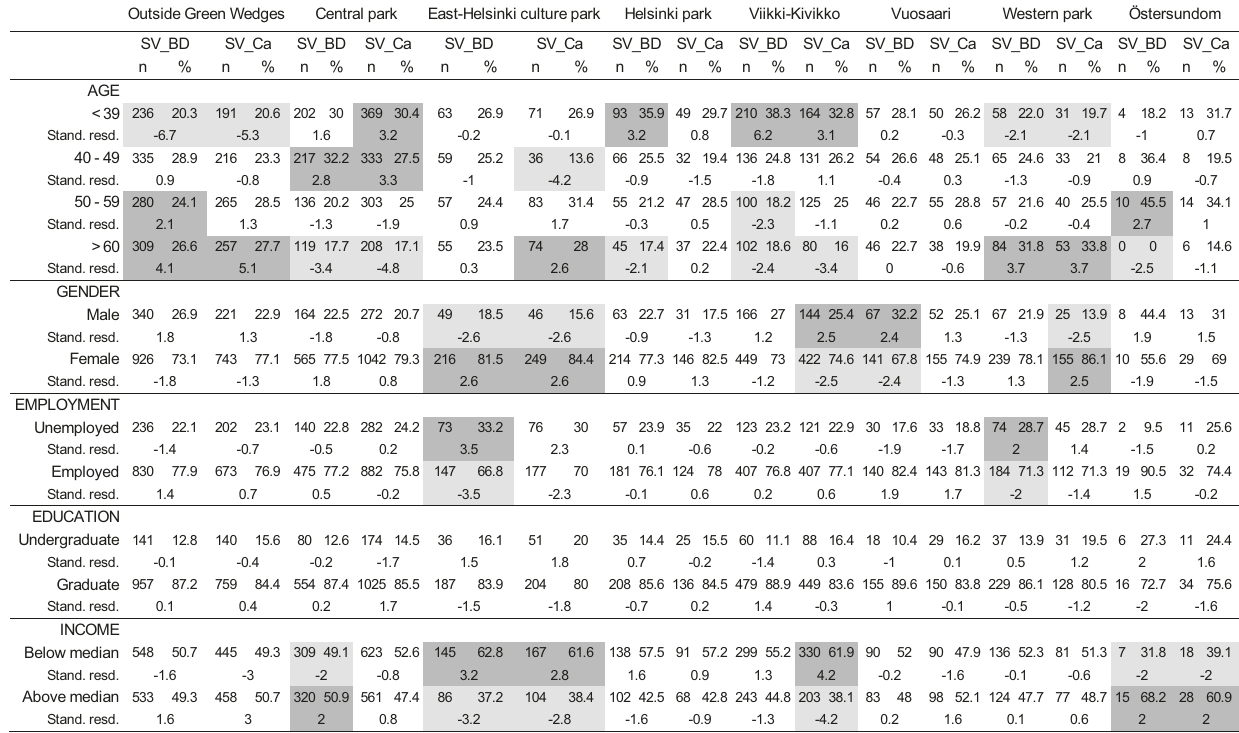
Table 1. Sociodemographic comparison between mapped social values for biodiversity (SV_BD) and carbon sequestration and storage (SV_Ca) across Helsinki´s green wedges.